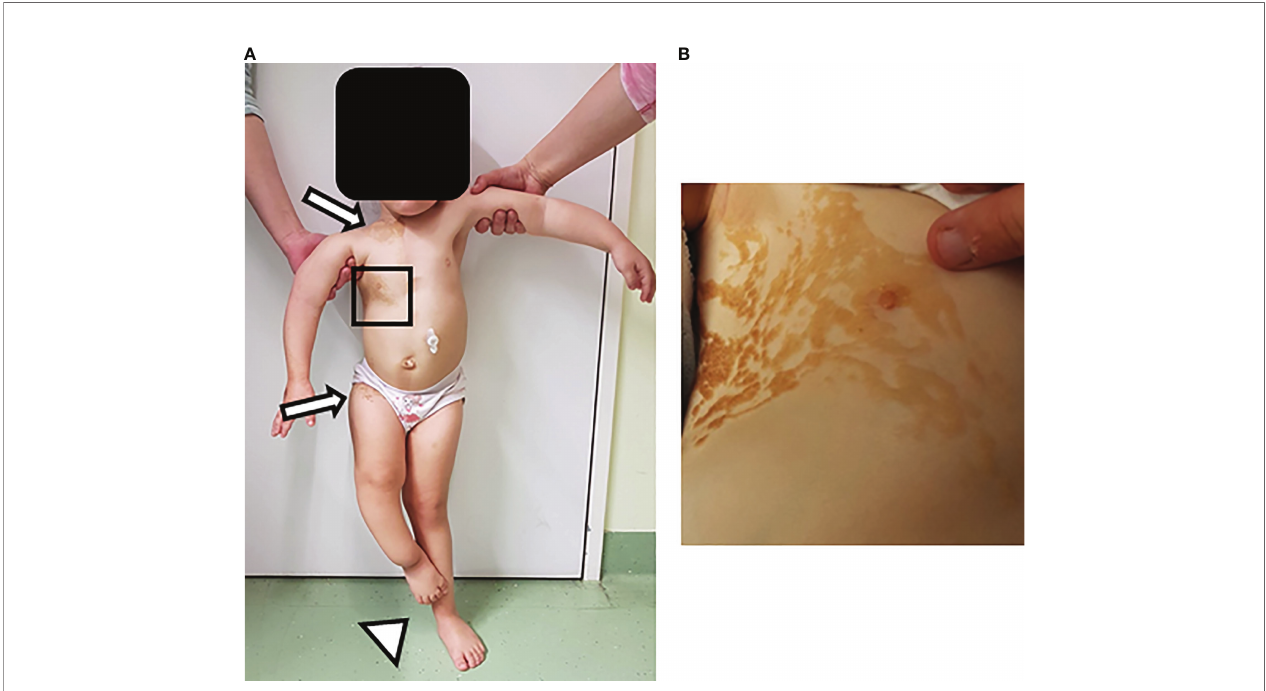
FIGURE 1 | Skin lesions in patient with Cutaneous-skeletal hypophosphatemia syndrome. Physical examination of a three-year-old female patient showed multiple clinical fi ndings, most prominently a linear nevus sebaceous. Additional features included asymmetric and age-inappropriate growth, accompanied by a leg length discrepancy, and a thoracic deformity with scoliosis. (A) Image shows overview image of the patient. Arrows point at the upper and lower end of the nevus sebaceous. Arrowhead points at the leg length discrepancy. (B) Image depicts inset of the nevus sebaceous of the upper right